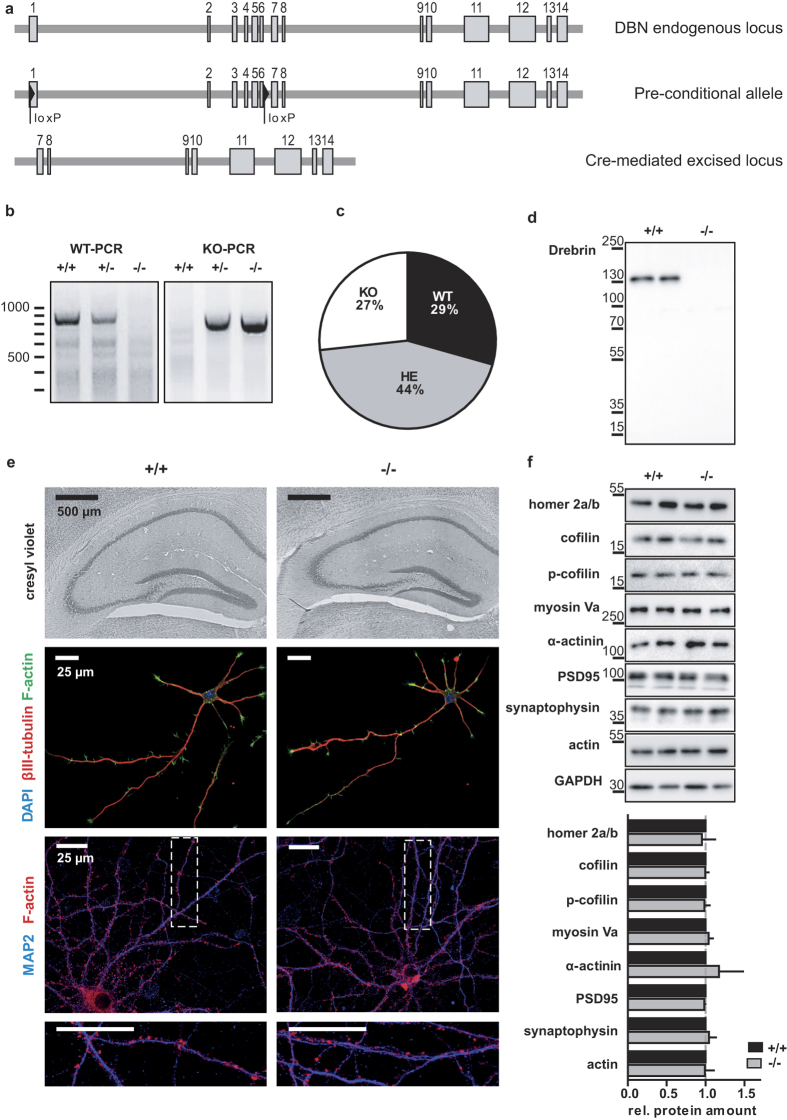
Generation of DBN knockout mice.(a) Schematic representations of the mouse Drebrin (DBN) genomic locus, targeted alleles and excision of the coding exons by Cre recombinase. Endogenous DBN contains 14 exons. Protein coding segments are shown as grey rectangles. LoxP sites are indicated by black triangles, The DBN locus after Cre-mediated excision corresponds to the constitutive DBN KO. (b) Verification of DBN KO PCR by using two different forward primers, for wild type (WT) in exon 6, for DBN knockout (KO) upstream of exon 1 and one reverse primer in the region between exon 6 and 7, PCR results for WT allele show 844 bp and for KO allele show 650 bp. Heterozygous mice presented bands in both PCR condition. Lines indicate DNA ladder in base pairs (bp). (c) Mendelian distribution of DBN deficient progeny (total number of litters analysed: 18; total number of mice: wild type (WT): 32, heterozygous (HET): 46, knockout (KO): 30). (d) Representative western blot from WT and KO mouse hippocampus lysates probed with DBN specific peptide antibody recognizing an epitope between Cys651 and Phe662 of the adult isoform. Lines indicate protein ladder in kilodalton. (e) Nissl staining showed no gross abnormalities in morphology of hippocampal area. Primary neuronal cultures prepared from DBN KO embryos showed no abnormalities in neurite outgrowth at DIV3 or spine size and number at DIV 21. (f) Hippocampus lysates were probed for different pre- and post-synaptic marker proteins as well as actin binding proteins. Western blot band densitometry revealed no altered protein levels for DBN KO samples compared to WT. Data show mean ± s.e.m. of 3 experiments.